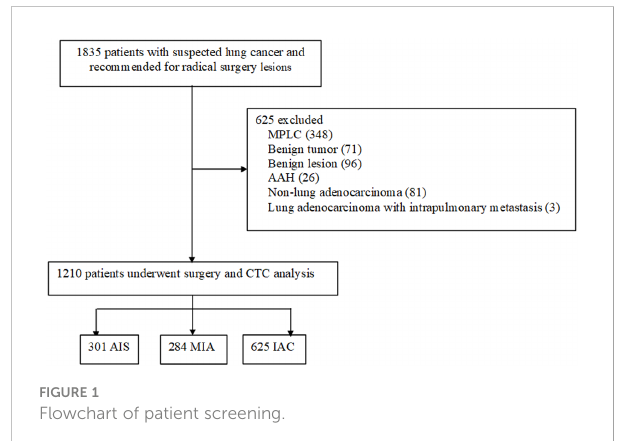
FIGURE 1 Flowchart of patient screening.